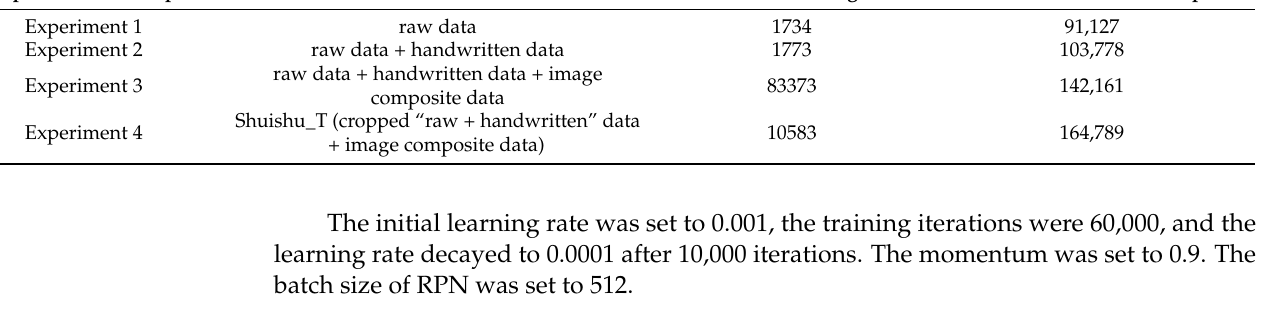
Table 7. Results of each experiment.